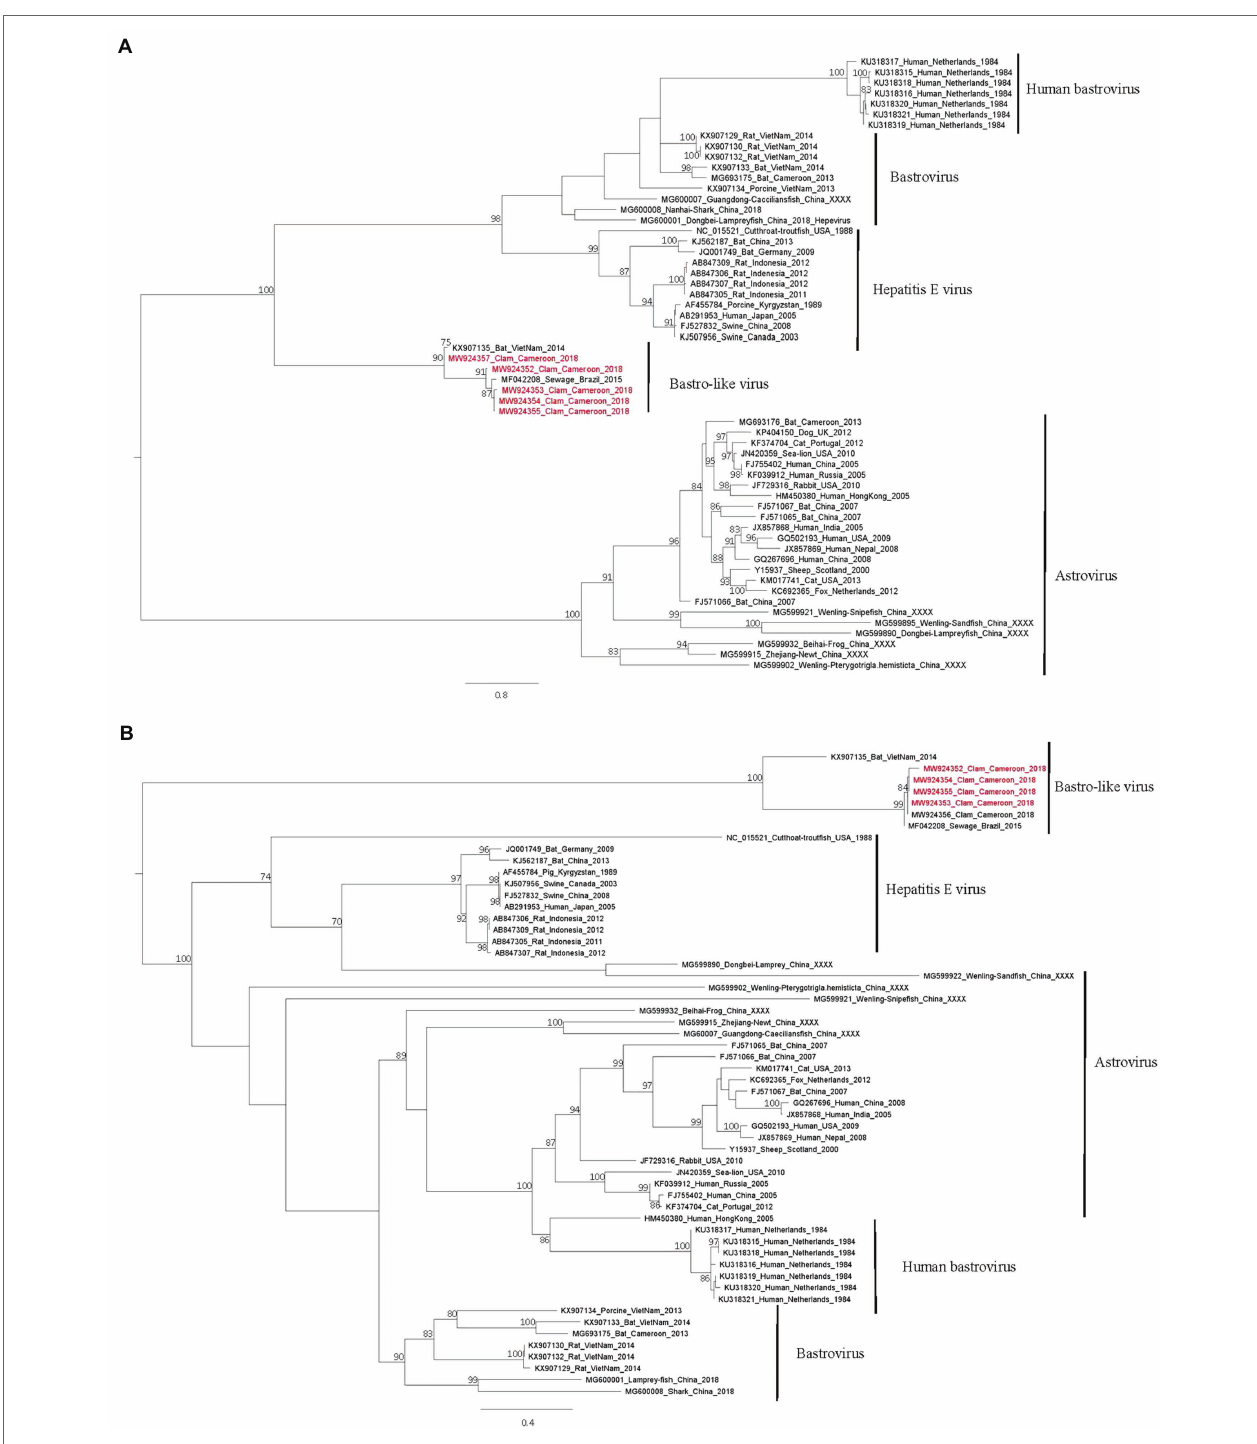
FIGURE 5 | Phylogenetic trees of the Astroviridae family based on Rdrp (A) and capsid (B) proteins. Reference sequences were selected for the main genus of the Astroviridae family, sequences identified in this study are written in red. The tree was constructed using IQtree with the LG + I + G4 substitution model for the RdRp and the LG + G4 model for the capsid and ultrafast bootstrap analysis. Trees were mid-rooted using FigTree and boostrap values greater than 70% are